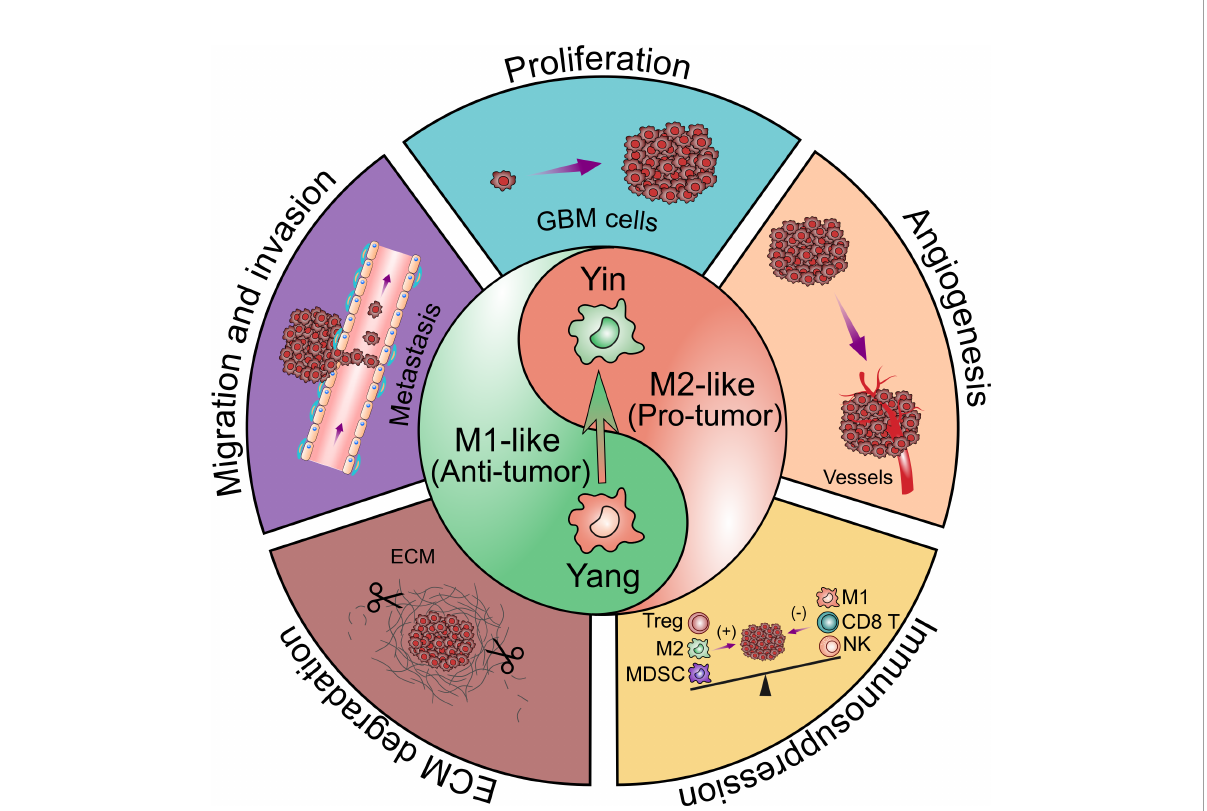
FIGURE 3 Contribution of glioblastoma-associated microglia and macrophages to tumor progression. TAMs have bimodal, yin and yang effects on immune responses. The yin and yang microglia/macrophage subtypes refer to M2- and M1-like respectively. M1-like TAMs are relative with the pro-in fl ammatory property while M2-like TAMs are relative with the anti-in fl ammatory property. The polarization of TAMs from M1 to M2 phenotype is associated with the tumor progression. TAMs are believed to promote GBM progression by several pro-tumorigenic activities including: 1) promoting GBM cells proliferation; 2) promoting GBM cells migration and invasion; 3) promoting angiogenesis in GBM; 4) facilitating extracellular matrix (ECM) degradation; 5) facilitating the immunosuppressive